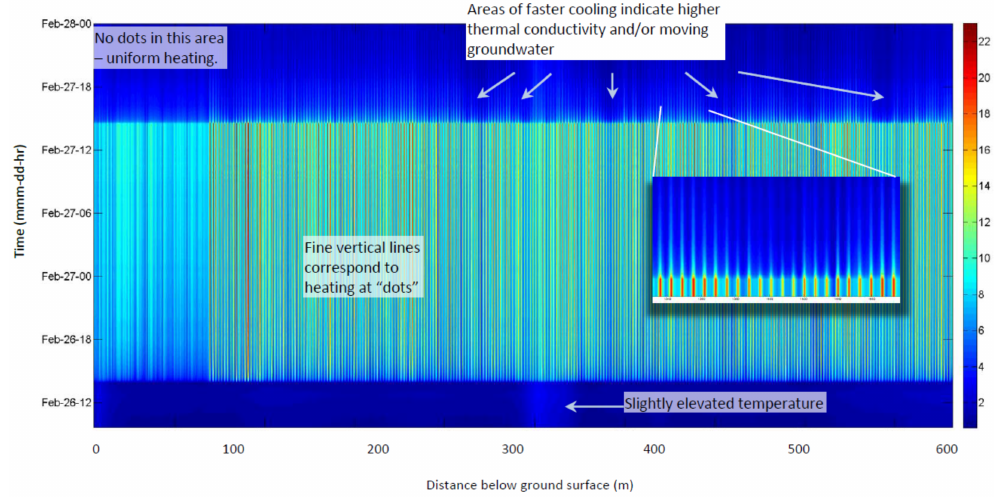
Figure 7. Change in temperature due to energizing dotted-line heater 26–28 February 2012. Time progresses upward, so bottom blue area is pre-heating, vertical lines correspond to locations of concentrated heating (dots); the top blue area is cooling after